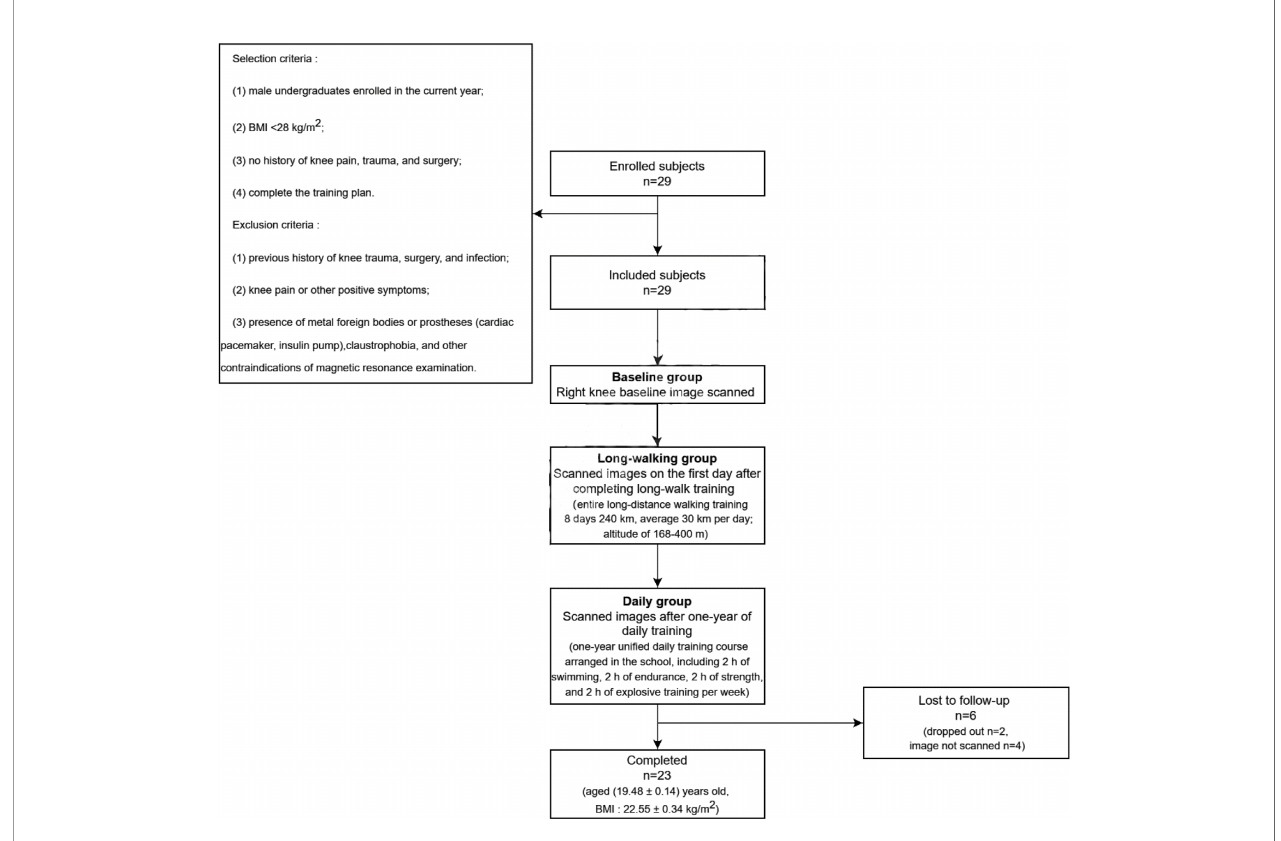
FIGURE 1 | Flow chart of the